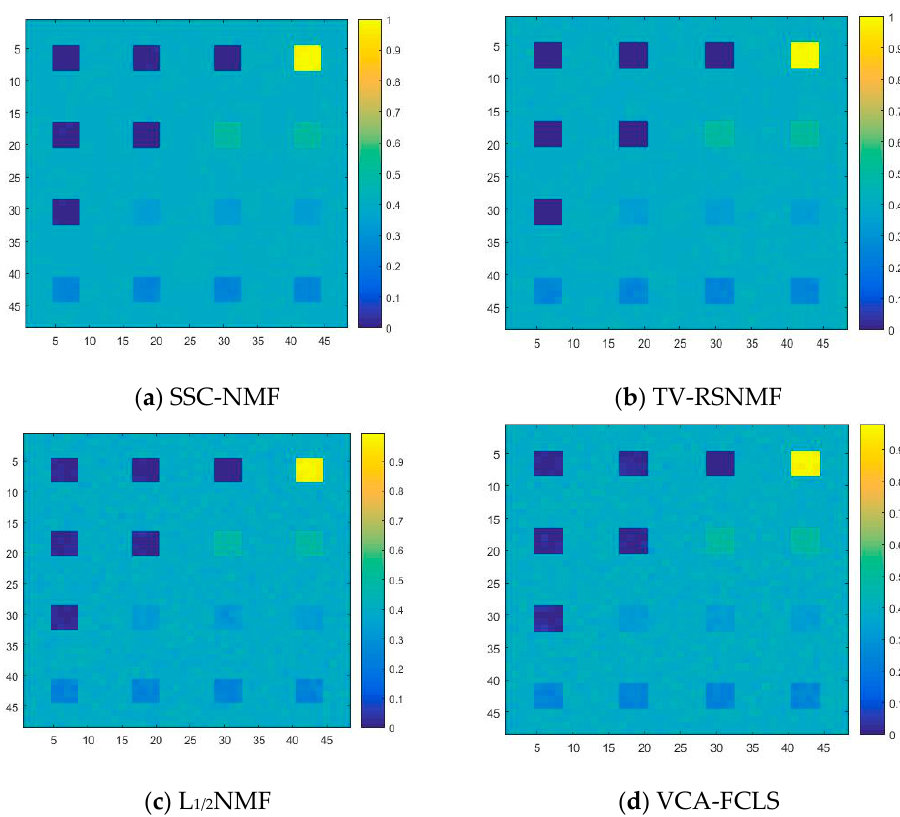
Figure 6. Comparison of the end-member signatures extracted by the SSC-NMF method with the reference spectra.